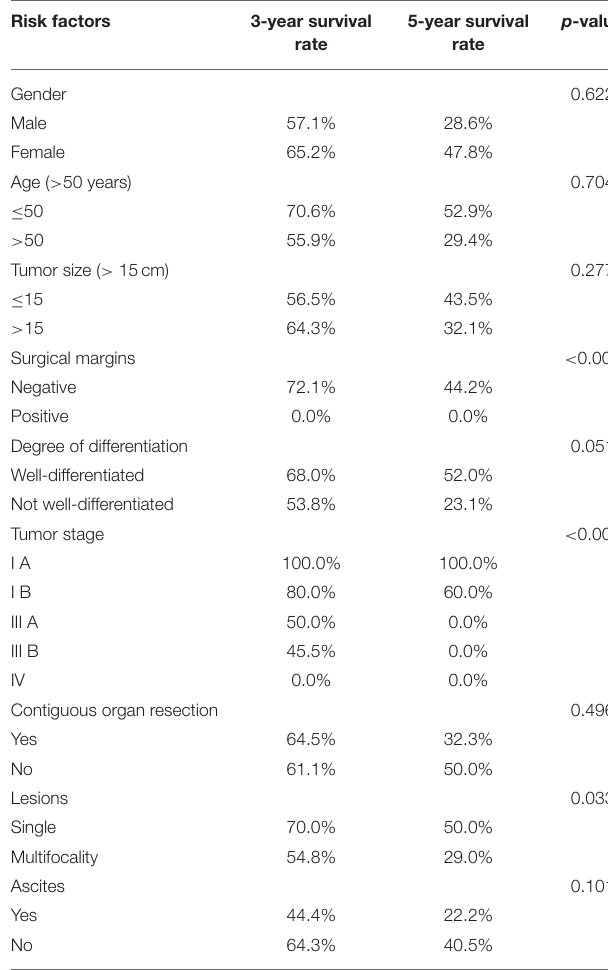
TABLE 3 | Risk factors for overall survival after operation ( p -values of the Tarone-ware test are presented).